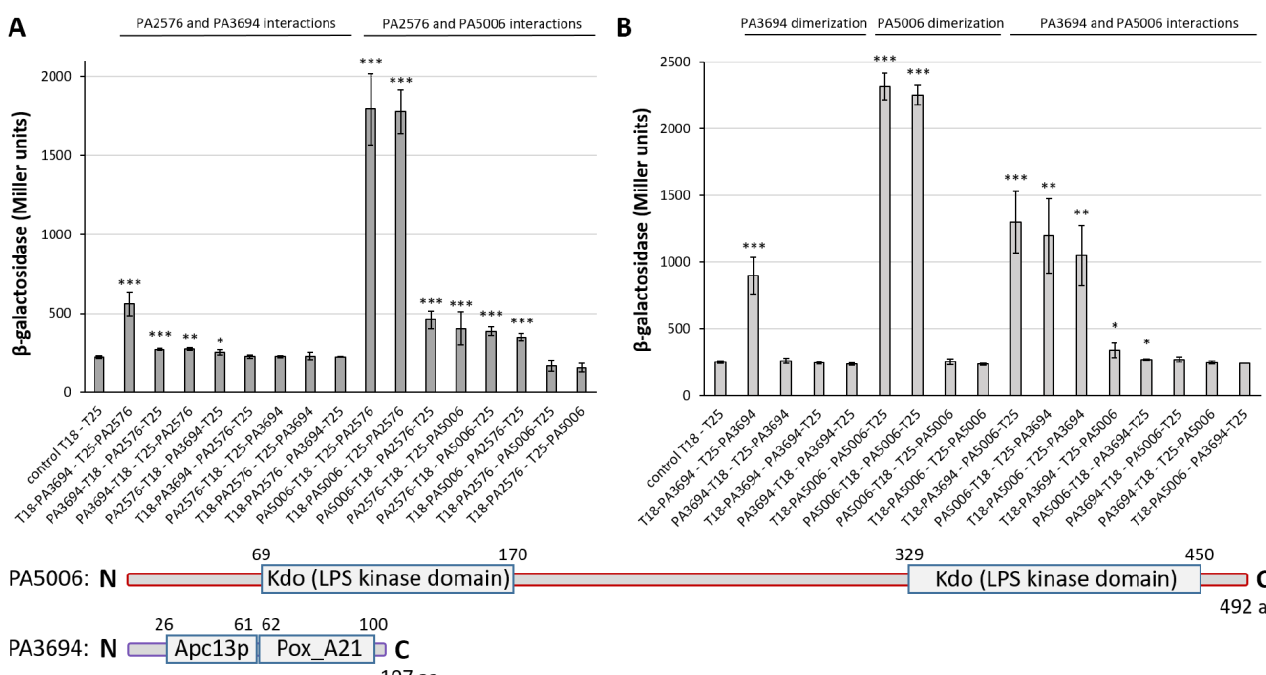
Figure 5. BACTH analysis of ( A ) PA2576 interactions with its two identified partners—PA5006 and PA3694—and ( B ) PA5006 and PA3694 self-interactions and interactions between each other. Data represent the mean ± SD values of β -galactosidase activities from three independent cultures of E. coli BTH101 cyaA − double transformants. Statistical significance was evaluated by t -test using measurements for transformants carrying double empty vectors as a control (* p -value < 0.05, ** p -value < 0.01, *** p -value < 0.001). The schematic domain structure of PA5006 and PA3694 proteins (based on the Kyoto Encyclopedia of Genes and Genomes (KEGG) database) is presented below the charts.